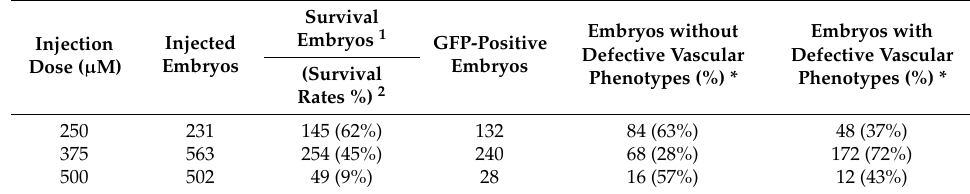
Table 4. Morphological phenotypes of zebrafish embryos (fli1/gata1) derived from fertilized eggs injected with HAS2